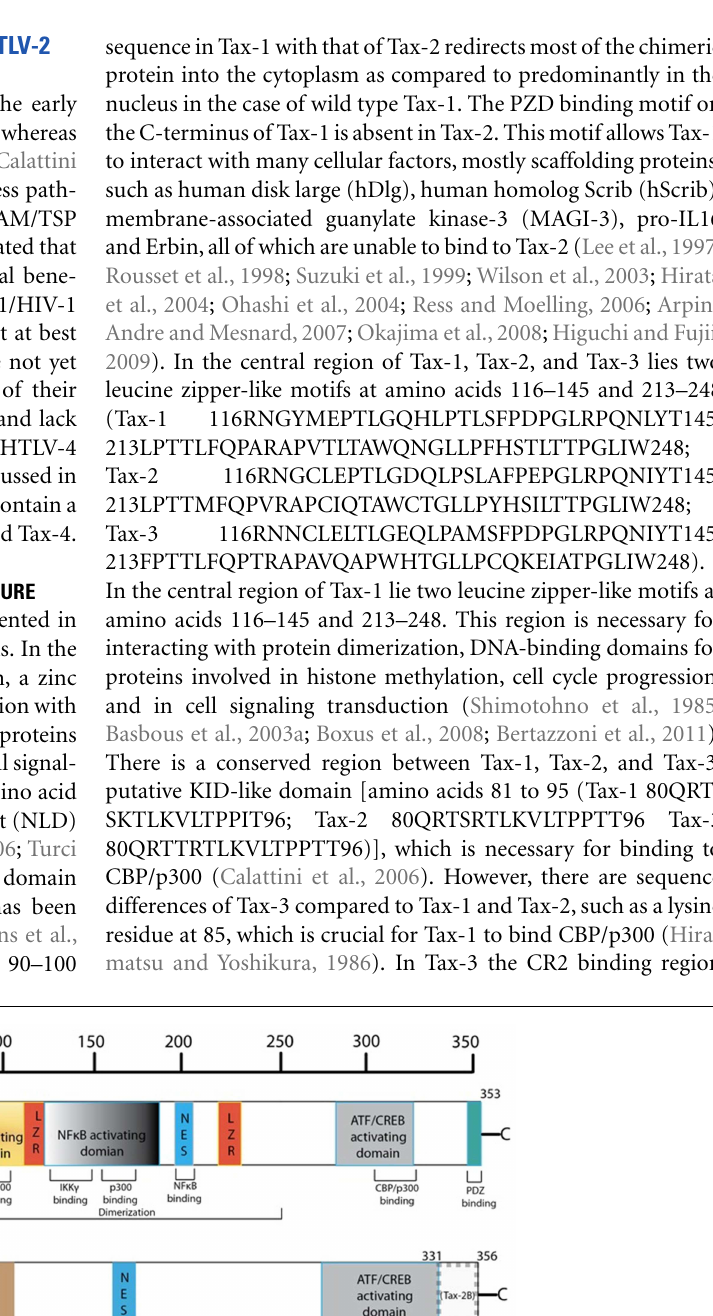
binding sequence, NF- κ B binding domain as well as PDZ binding motif are shown.Tax-2A has 331 amino acid (aa) residues, whereasTax-2B has a 25 aa C-terminal extension, which is depicted in Figure 4 with a dotted